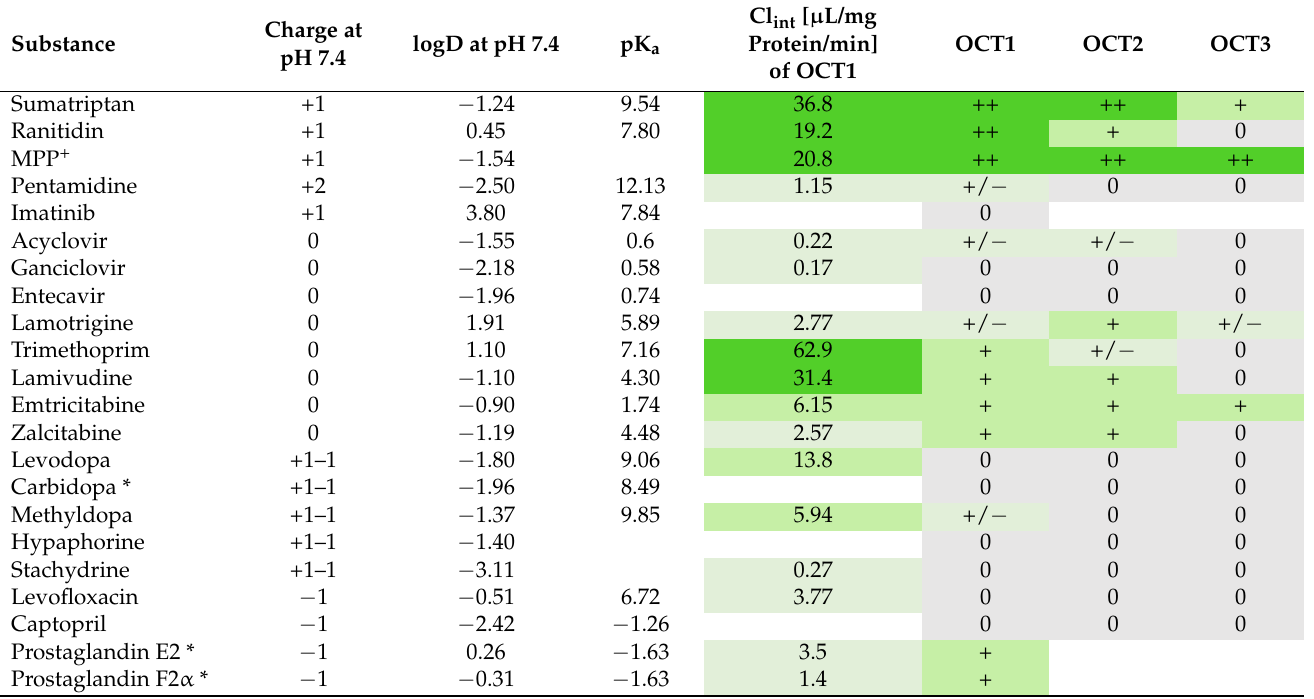
Table 3. Summary of the transport data for OCT1, OCT2, and